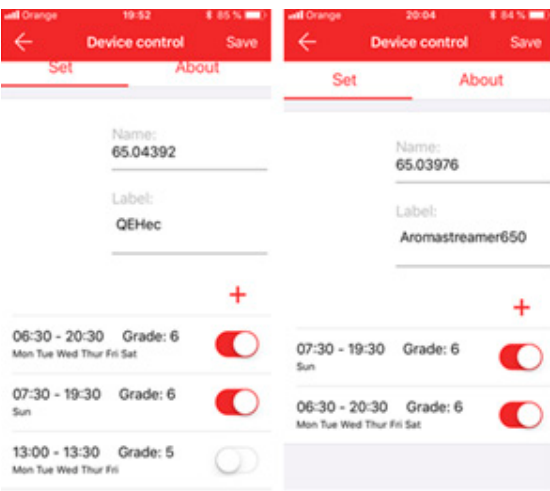
Figure 3. REIMA AirConcept mobile app for aromatising unit settings.